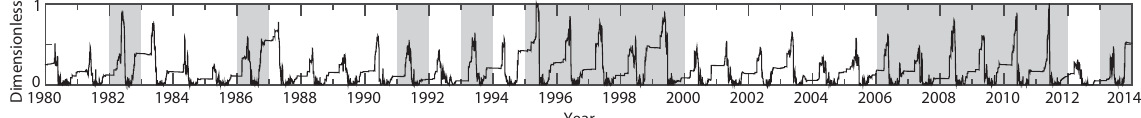
Figure A1. The soil-moisture parameter s (Eq. A1) for example BC2. The function s typically is largest during wet periods (shaded gray).